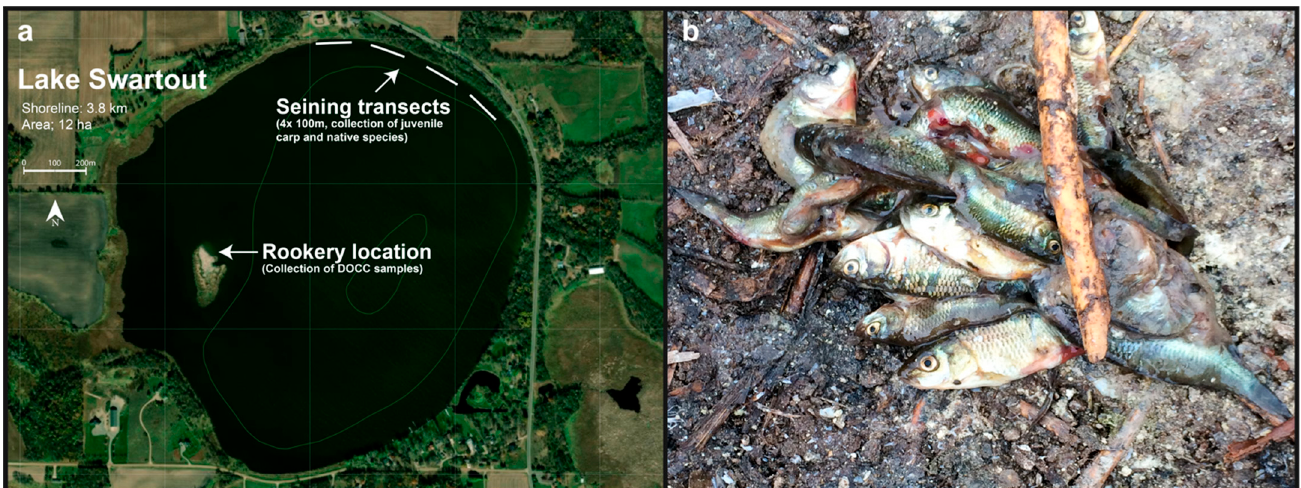
Figure 1. Lake Swartout. Panel ( a ) shows a satellite image of Lake Swartout and surrounding land usage. Seining transects from the collection of juvenile carp and native species and the Phalacrocorax auritus (DCCO) rookery site are denoted. Bathymetry contours are in 1.5 m increments. Panel ( b ) shows an image of juvenile carp in a DCCO regurgitant sample.